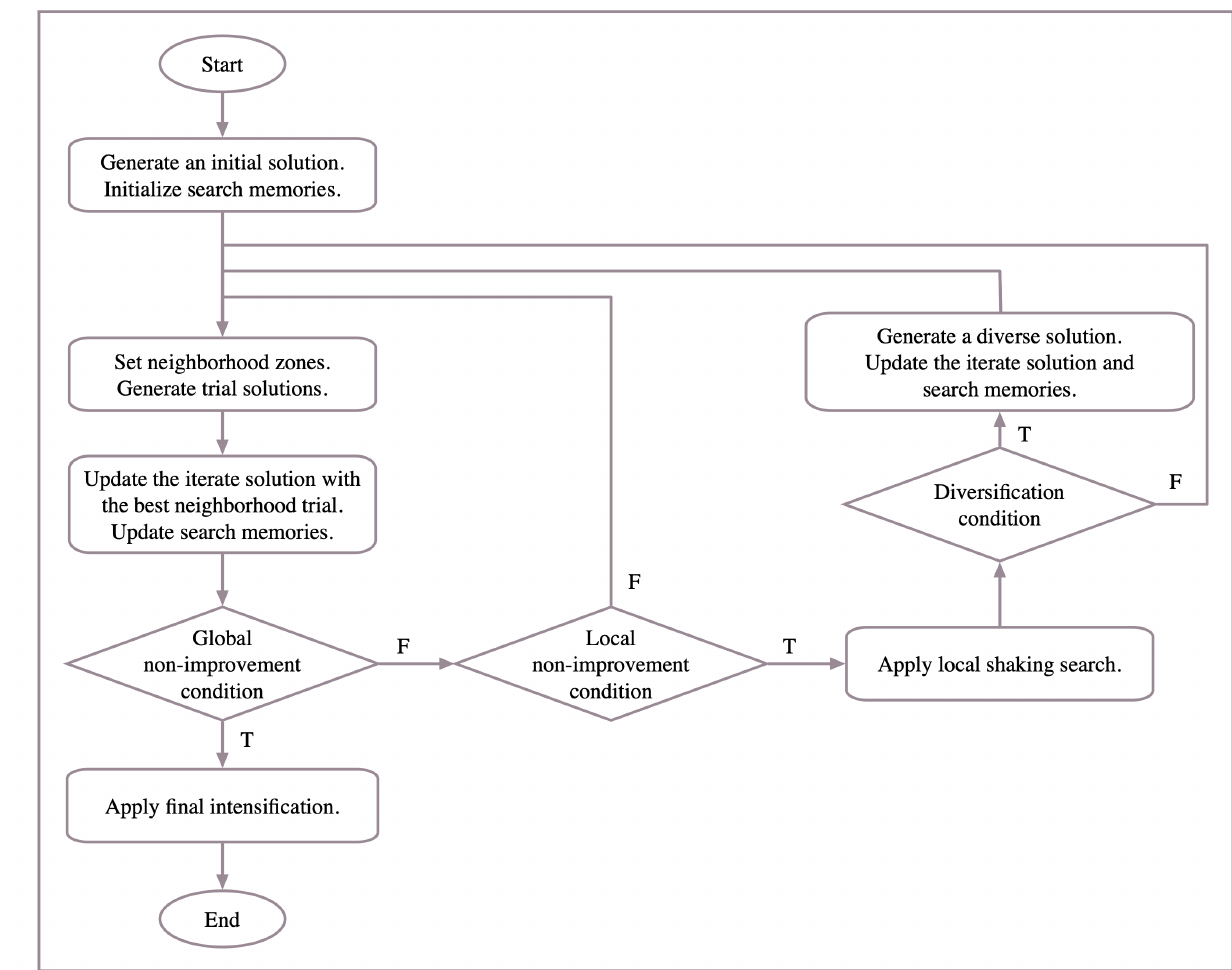
Figure 2. The flowchart of the proposed feature selection m TSAR